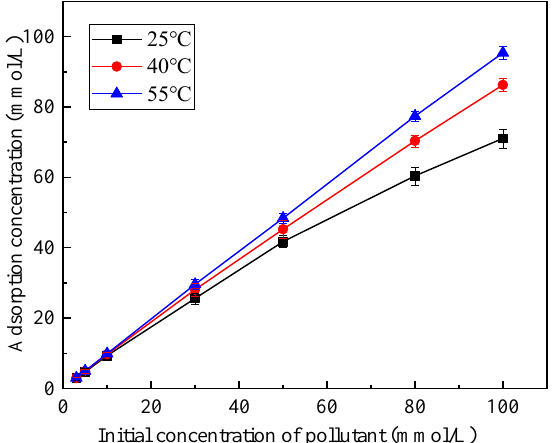
Figure 2. Relationship between initial concentration and adsorption removal rate. At 25 °C, 40 °C and 55 °C, the adsorption concentration of mixed soil on Zn (the adsorption strength of mixed soil on Zn in solutions with different concentrations) and the change rule of initial concentration are shown in Figure 3. At different temperatures, the adsorption concentration of Zn increased with the increase in the initial concentration of Zn. When the temperature was 25 °C, 40 °C and 55 °C and the initial concentration was 30 and 80 mmol/L, the adsorption concentration of Zn by the mixed soil was 25.57, 28.08, 29.60 and 60.42, 70.37, 77.42 mmol/L, respectively. Temperature has a significant effect on the adsorption concentration of Zn in the mixed soil. When the concentration is fixed, the adsorption concentration of Zn in the mixed soil increases with the increase in temperature. When the concentration is 100 mmol/L, the concentration of Zn in the mixed soil is 71.09, 86.27 and 95.40 mmol/L at 25 °C, 40 °C and 55 °C, respectively.